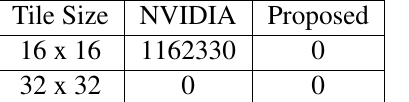
Table 4: Bank Conflicts with different tile sizes